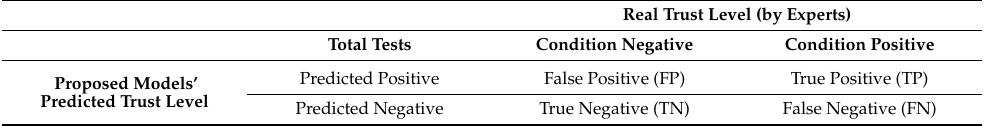
Table 3. Basic Indices